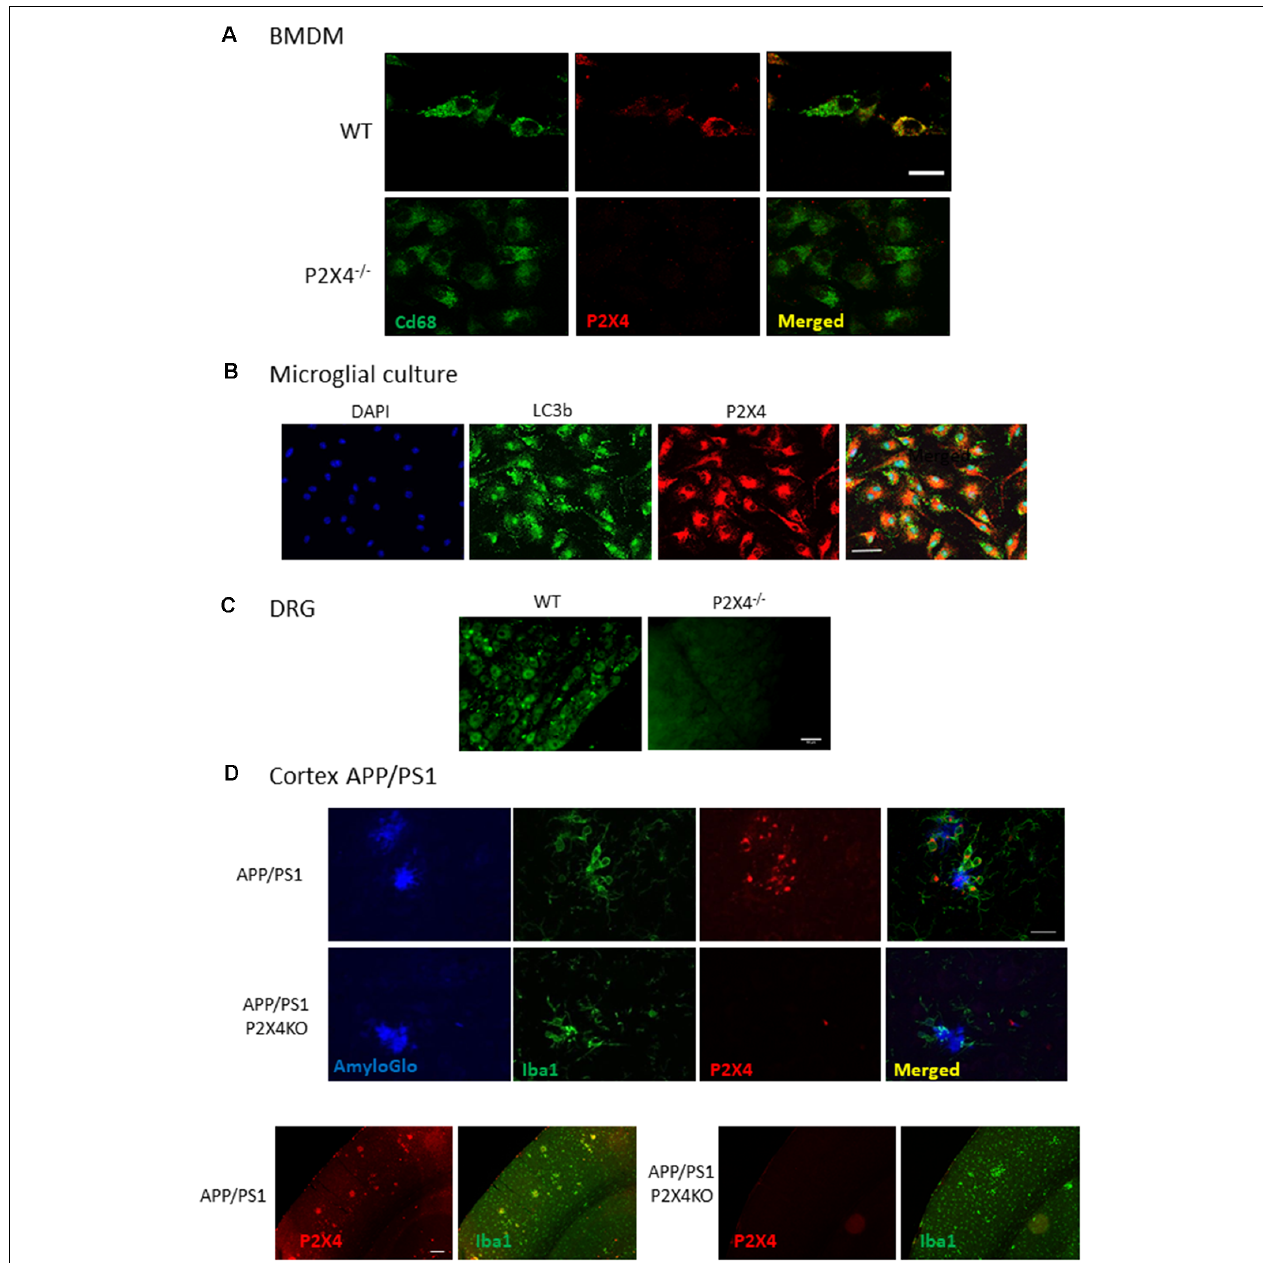
FIGURE 4 | Immunocyto- and -histochemistry with Nodu 246. (A) Co-immunostaining of WT and P2X4 − / − BMDM with Nodu 246 and the lysosomal marker CD68. Scale bar: 5 µ m. (B) Co-immunostaining of WT and P2X4 − / − cultured mouse microglia using the rat-monoclonal antibody Nodu 246 and the lysosomal marker LC3b. Scale bar: 10 µ m. (C) Immunostaining of dorsal root ganglion (DRG) of WT and P2X4 − / − DRG. Scale bar: 50 µ m. (D) Top panel, co-immunostaining of microglial cells (green, Iba1) and P2X4 (red, Nodu 246) and amyloid plaques (blue, AmyloGlo) in the cortex of brains from APP/PS1 and APP/PS1; P2X4 − / − mice. P2X4 is localized in the intracellular compartments of activated microglia clustered around amyloid deposits. Scale bar 20 µ m. Bottom panel, low magnification of the cortical region of APP/PS1 and APP/PS1; P2X4 − / − mice stained with anti-Iba1 (green) and Nodu 246 (red). Note the dim P2X4 immunostaining in cortical neurons. Scale bar 50 µ